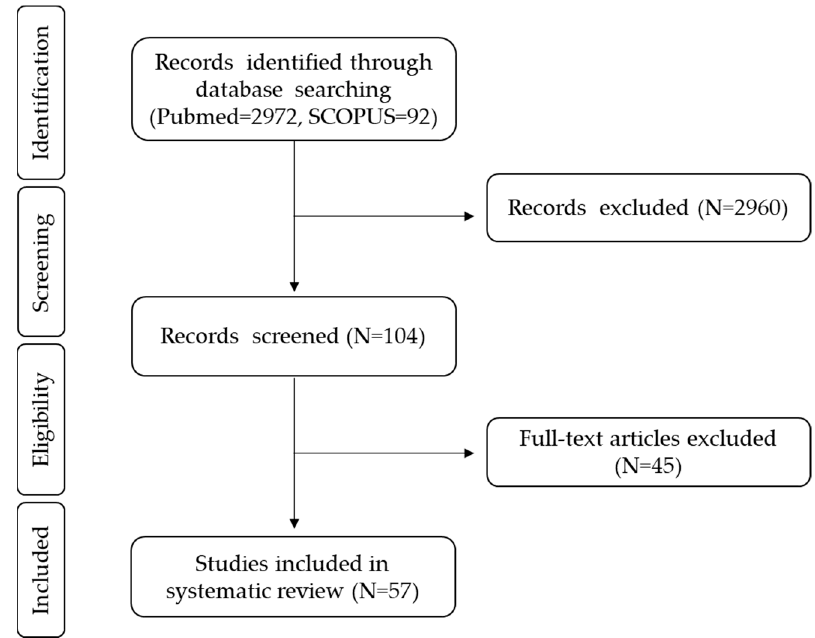
Figure 2. PRISMA flow chart. PRISMA flow chart of studies focused on diet effects on the gut microbiota of healthy adults.